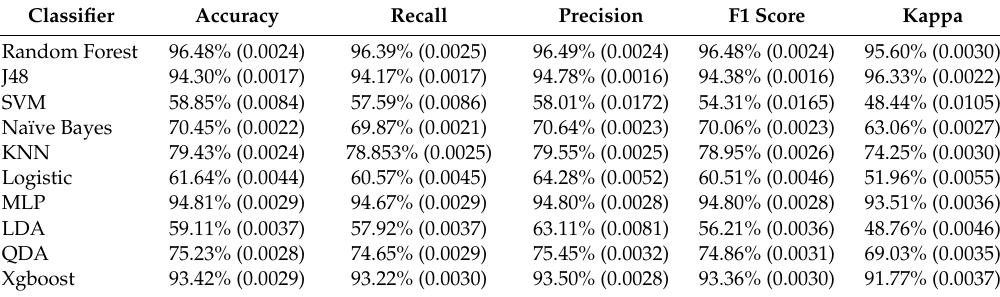
Table 9. ML-based classifier performance on Day-1 dataset.